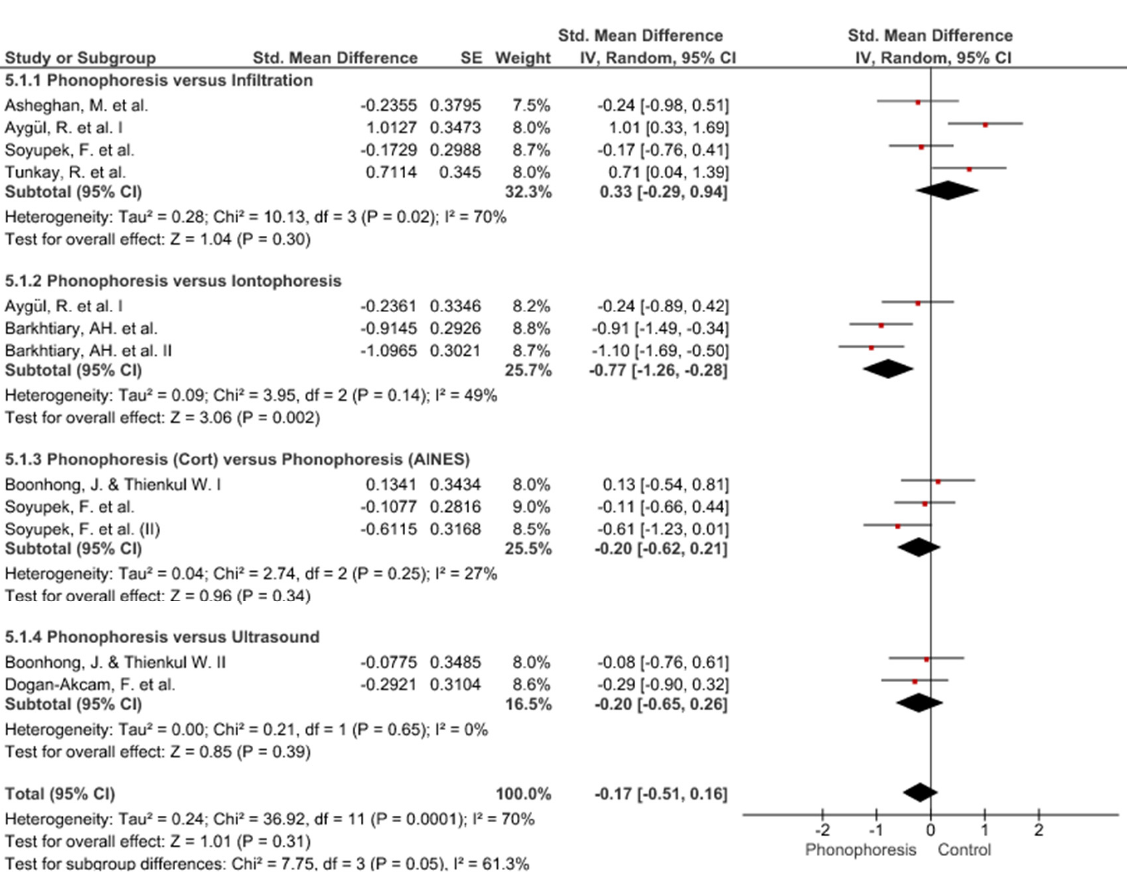
Figure 6. Phonophoresis for LMMotor.